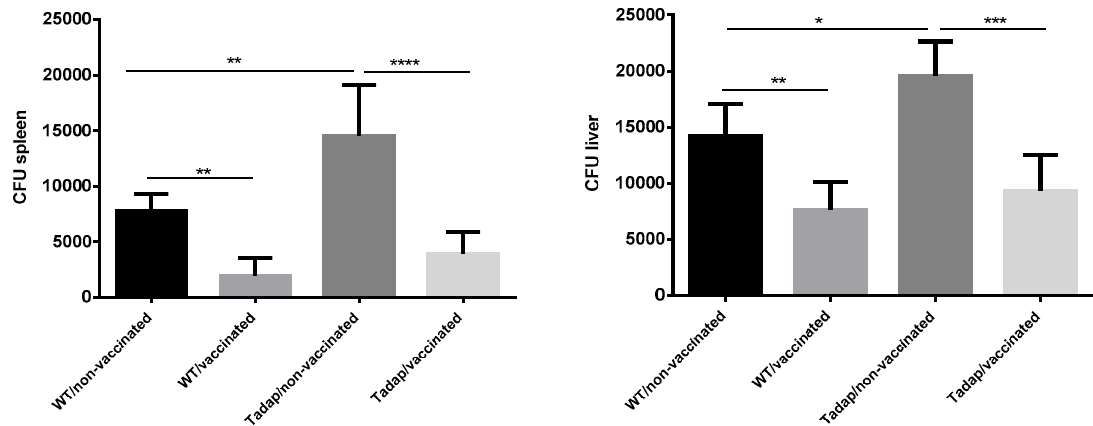
Figure 6. Vaccination with PGA+rSsEno was able to reduce the fungal burden in spleen and liver of mice infected with either wild type (WT) or toluene adapted S. schenckii (Tadap). Balb/c mice were injected (s.c.) twice with PGA+rSsEno (vaccinated) or PBS (non-vaccinated). One week after the boost, mice were i.p. challenged with S. schenckii and seven days after infection the protection was assessed by the number of CFUs recovered from the spleen and liver. * ( p < 0.05); ** ( p < 0.01); *** ( p < 0.001); **** ( p < 0.0001).